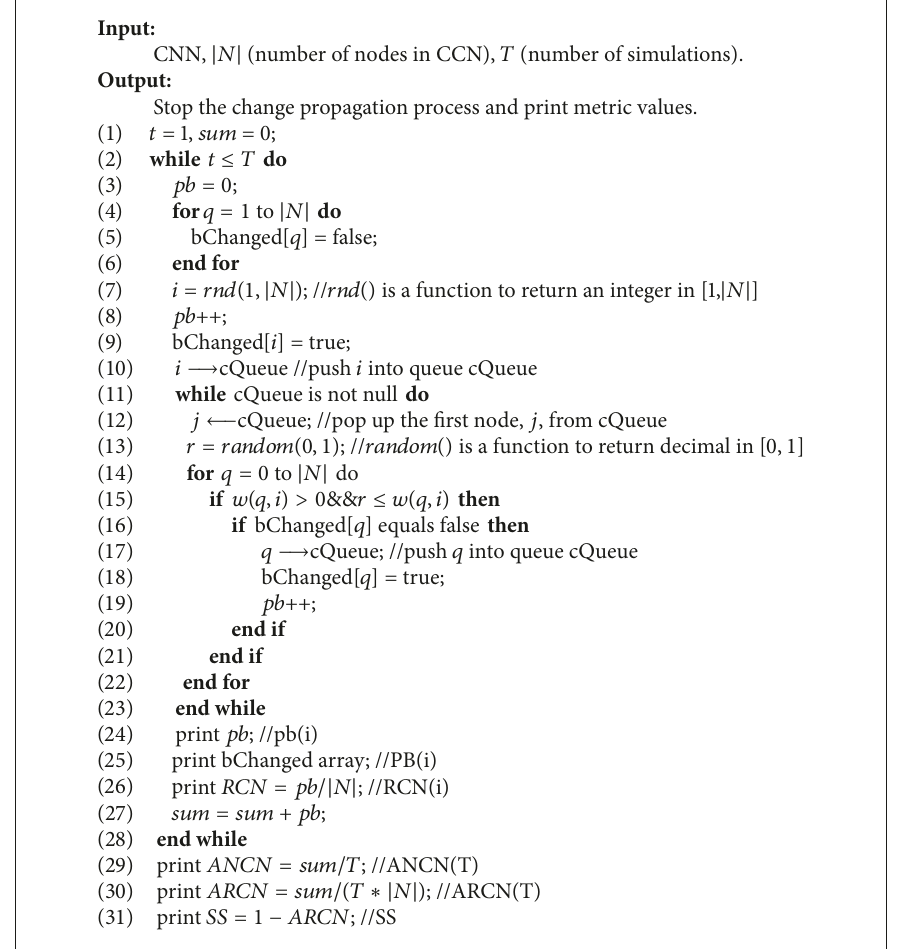
Algorithm 1: Flow of the change propagation algorithm.